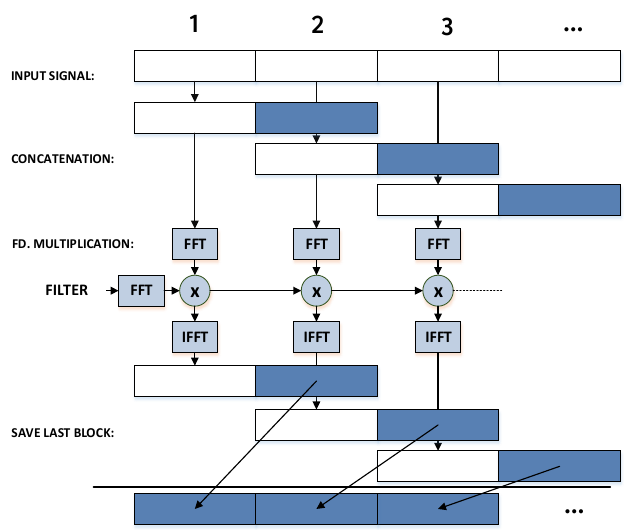
Figure 2. Graphical illustration of the overlap-save technique.